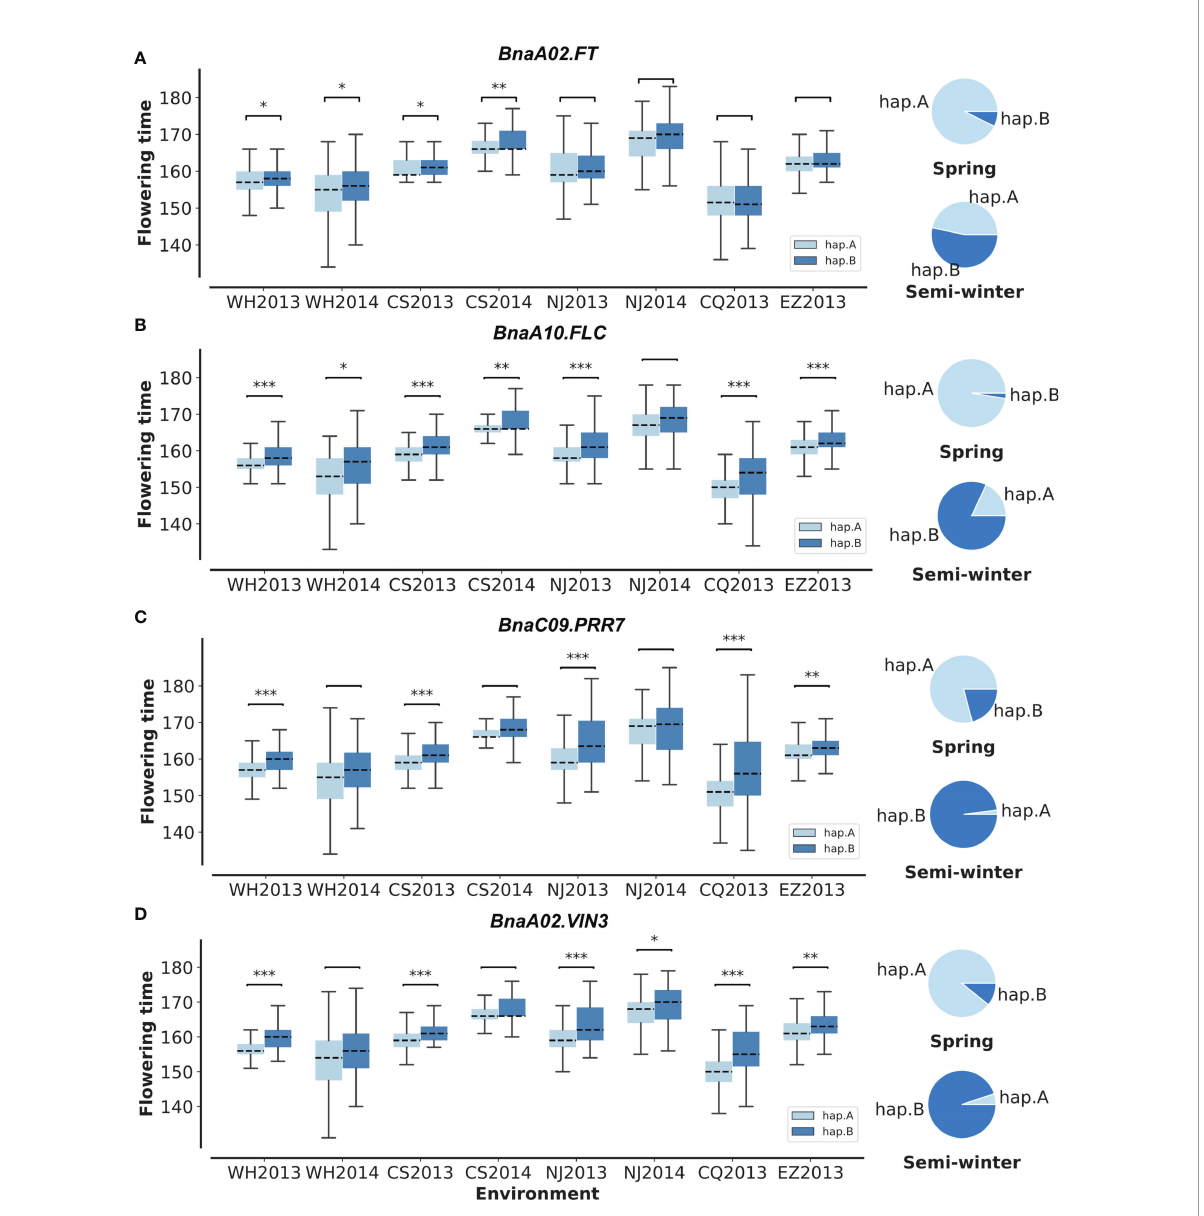
FIGURE 4 Haplotype analysis of BnaC02.FT , BnaA10.FLC , BnaC09.PRR7 , and BnaA02.VIN3 (A – D) . In the boxplot, signi fi cant differences for fl owering time between each haplotype are calculated in eight environments with t -test. In pie plots, the haplotype frequencies of each gene in semi-winter and spring oilseed rapes are marked. WH2013, Wuhan in 2013; WH2014, Wuhan in 2014; CS2013, Changsha in 2013; CS2014, Changsha in 2014; NJ2013, Nanjing in 2013; NJ2014, Nanjing in 2014; CQ2013, Chongqing in 2013; EZ2013, Ezhou in 2013. * p = 0.05, ** p = 0.01, and *** p =